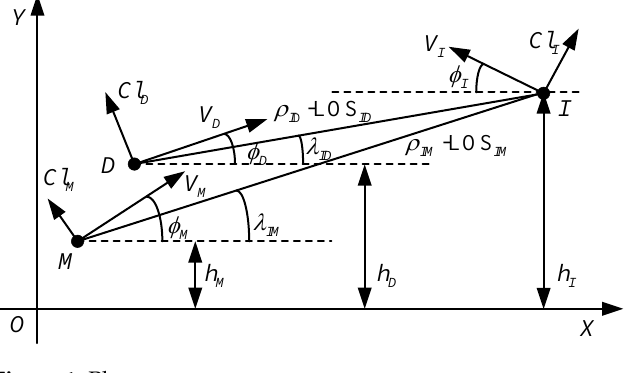
Figure 1. Planar engagement geometry.